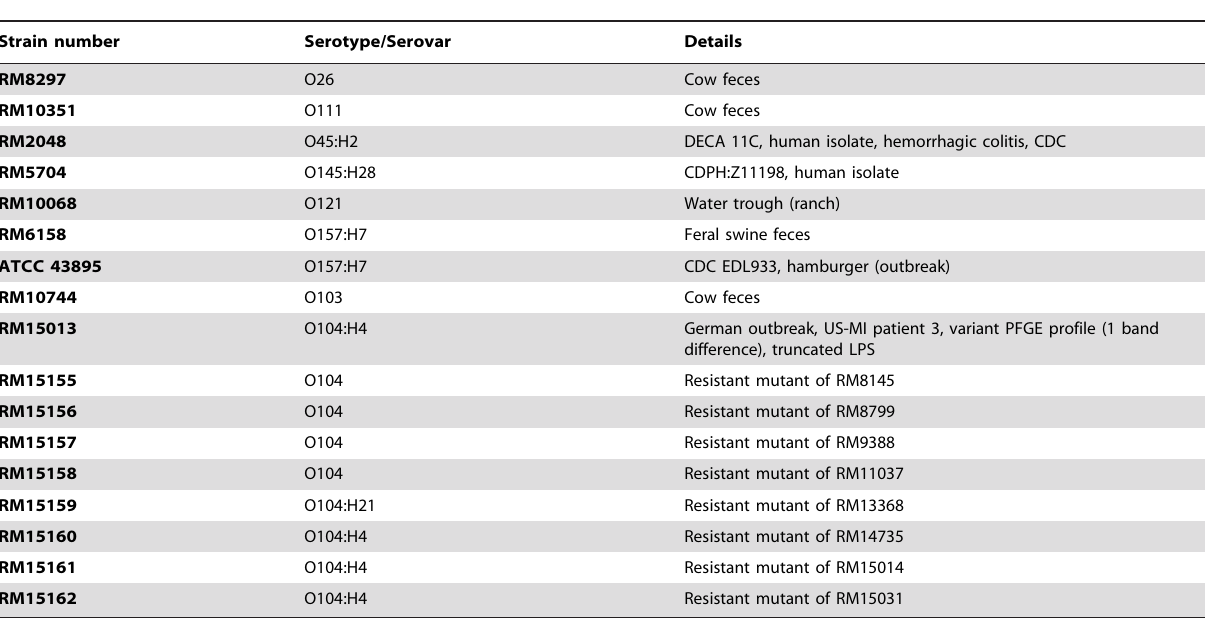
Table 2. E. coli strains resistant to AvR2-O104.1.